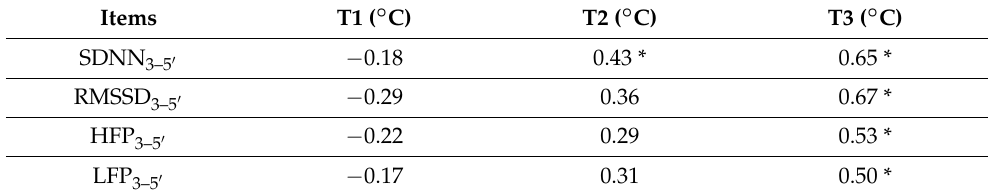
Table 6. Pearson correlation between thermal parameters and recovery heart rate variability